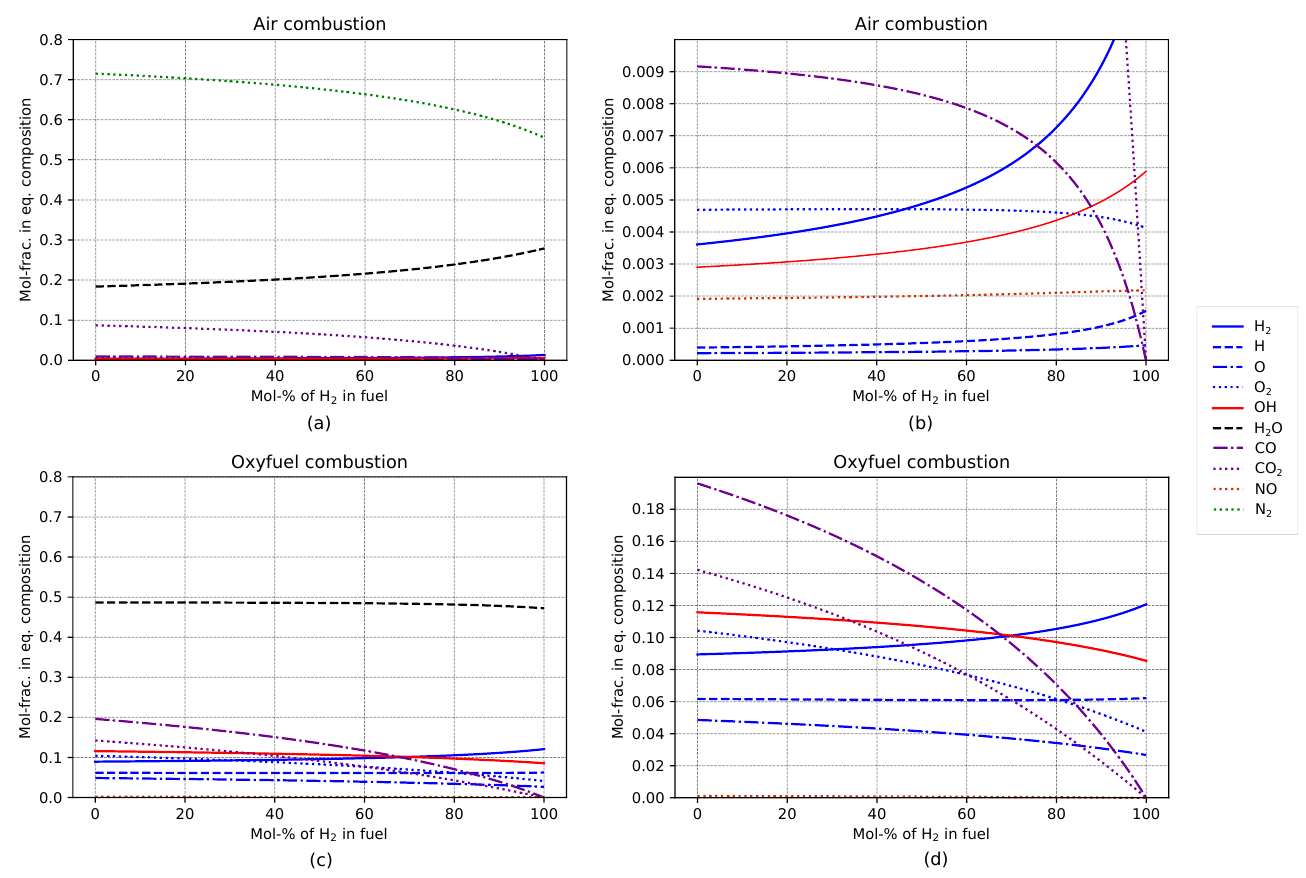
Figure 9. Predicted equilibrium composition of the gas mixtures after adiabatic combustion. ( a ) Main products of fuel- air combustion, with N 2 , H 2 O and CO 2 being the dominant products. ( b ) Highlight of the minor products of fuel-air combustion, i.e., CO, O 2 , H 2 , OH, NO, H and O. Despite their low mole fractions, CO and NO, in particular, have a significant impact on adiabatic flame temperatures. The other species can be considered negligible for adiabatic flame temperature investigations. ( c ) Main products of fuel-oxyfuel combustion with H 2 O, CO, CO 2 , OH and O 2 being dominating products. ( d ) Highlight of the minor products of fuel-oxyfuel combustion, i.e., H 2 , H and